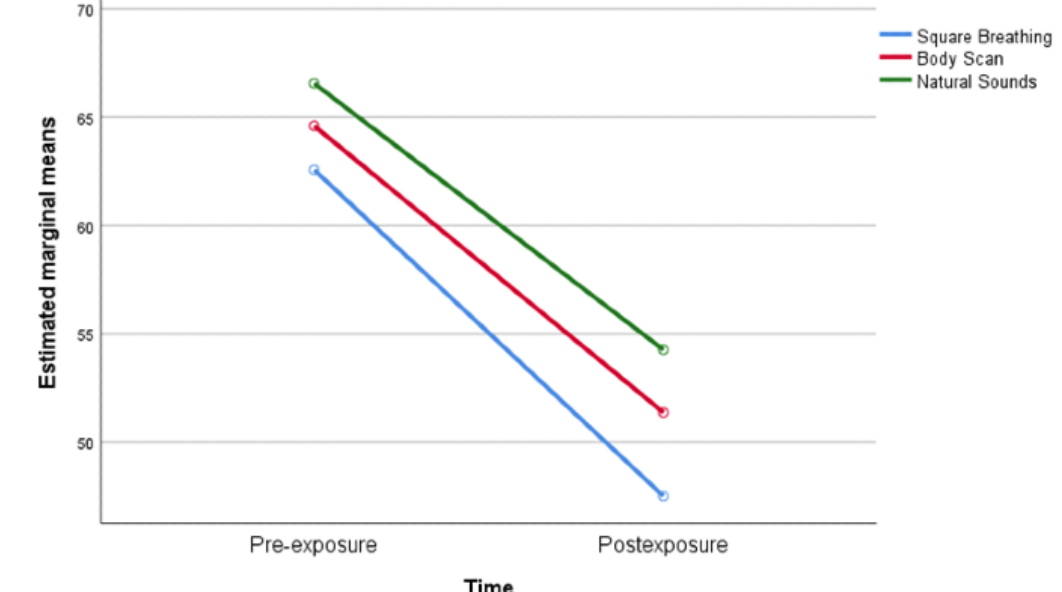
Figure 3. Thoughts related to